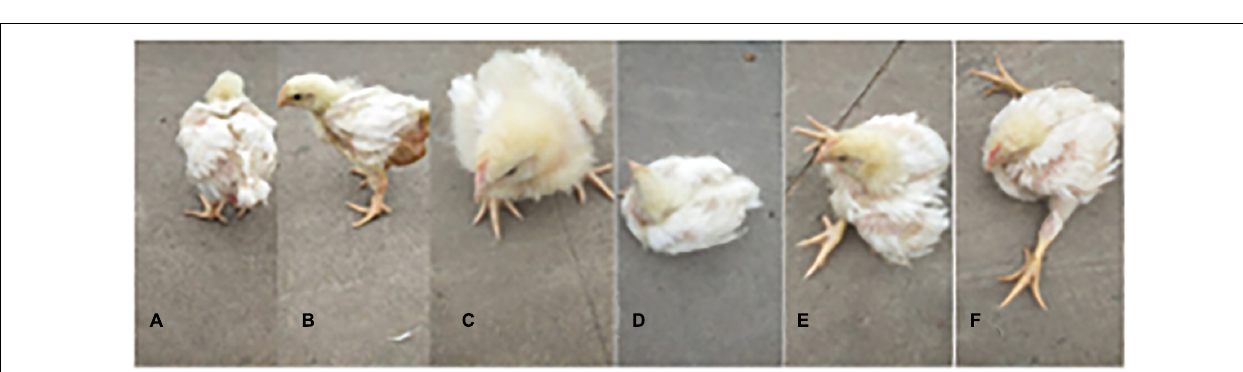
FIGURE 2 | The varying degrees of gait changes in broilers with FHN. Gait score of 0 (A) The bird walked normally, with no detectable abnormality; Gait score of 1 (B) The bird had a slight defect, which was difficult to define precisely; Gait score of 2 (C) The bird had a definite and identifiable defect in its gait; Gait score of 3 (D) The bird had an obvious gait defect, which affected its ability to move about; Gait score of 4 (E) The bird had a severe gait defect; Gait score of 5 (F) The bird was incapable of sustained walking on its feet.